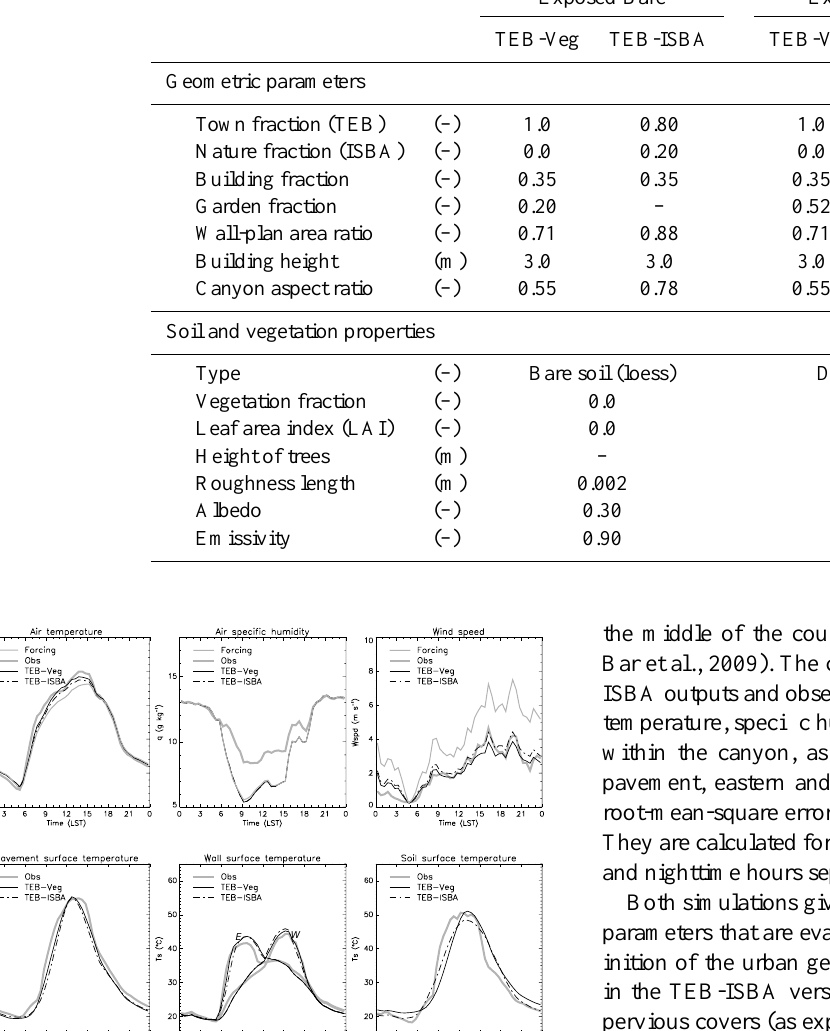
Table 2. TEB’s and ISBA’s input parameters according to the two landscaping strategies modelled with TEB-ISBA and TEB-Veg. Exposed-Bare